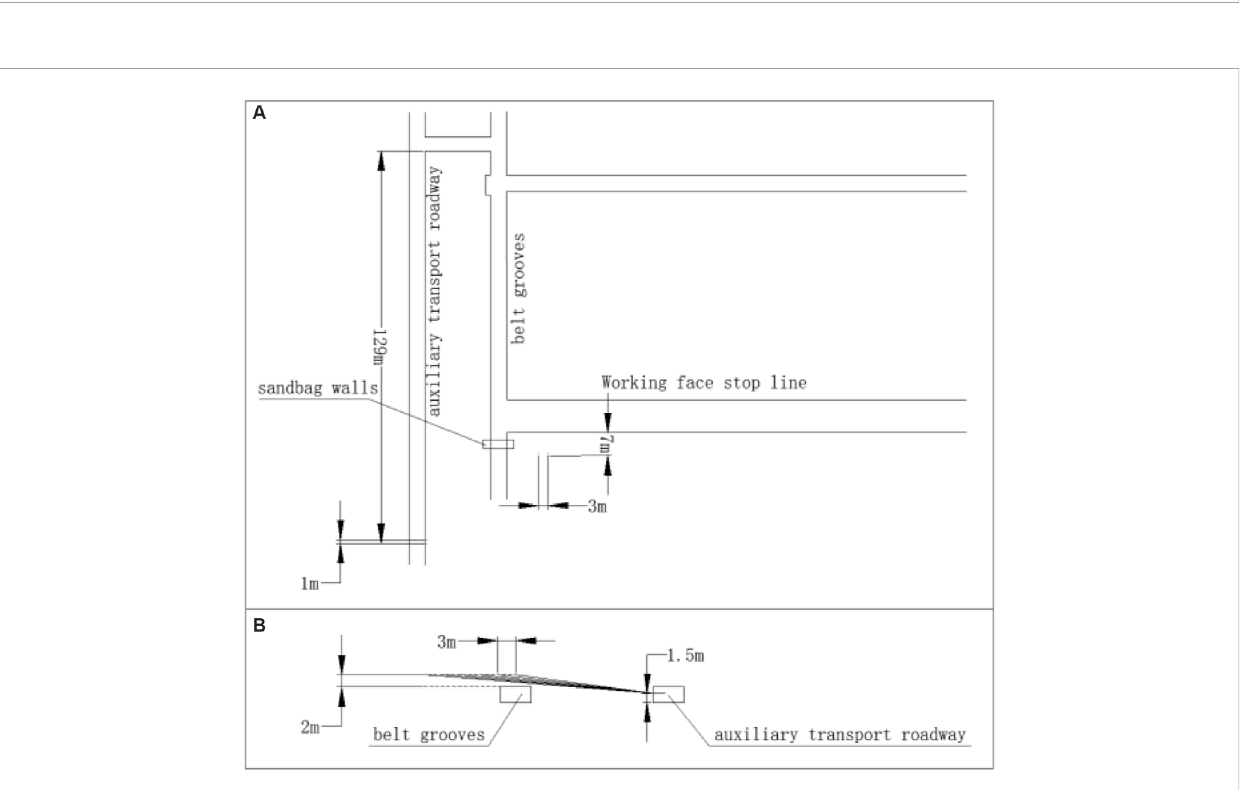
FIGURE 11 Schematic diagram of the inlet end injection (A) and (B) are the top view and main view of glue injection drilling construction, respectively).